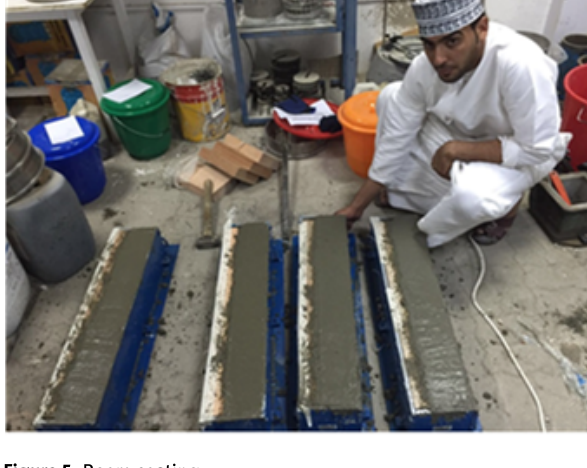
Figure 5: Beam casting.